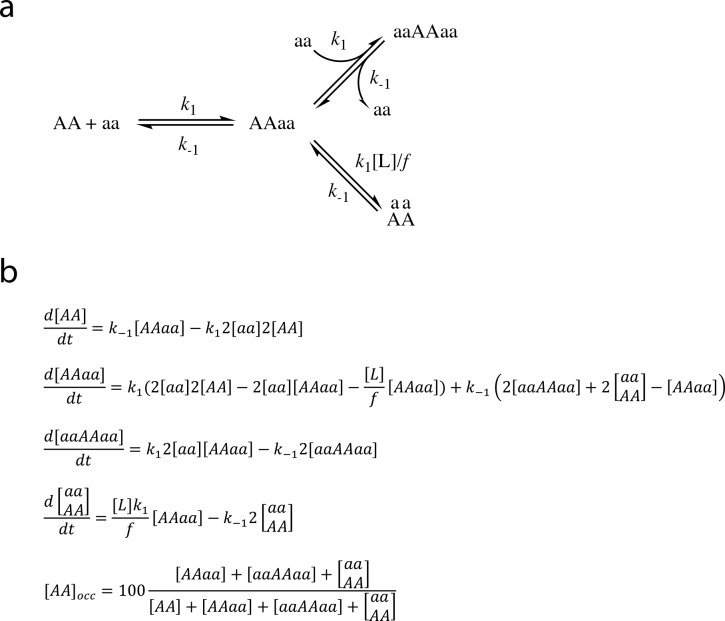
Differential equations to follow the time-wise changes in the different target species shown in Figure 4.(a) Abbreviated notation for the free and bound target species. As in Figure 4a, the different binding modes are designated by ‘AAaa’ for the partly complexes, by ‘aAAa’ for the fully bound bivalent complex and by ‘aaAAaa’ for the ternary complexes with two partly bound ligands. (b) Differential equations used for simulating the time-wise changes in the different target species. k1 is the association and k-1 the dissociation rate constants for the monovalent binding. When PICK1 is only attached via one of its PDZ domains the second PDZ domain can only move within half of a sphere with a radius, r, corresponding to the maximal distance between the two PDZ domains. The local concentration of the second PDZ domain, [L], can be calculated as showed in Figure 4a. The penalty factor, f, is introduced to modulate the association rate constant of the second PDZ interaction (k2) in order to account for limited rotational freedom, sterical hinderance or structural rearrangements governing binding of the second PDZ domain. [AA]occ refers to the sum of all ligand-bound species and is expressed as percent of the total target population.